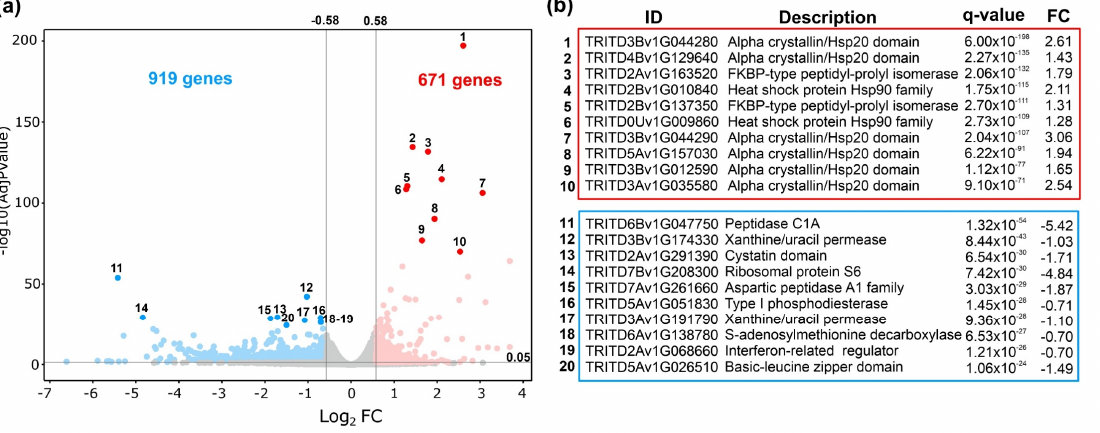
Figure 4. Volcano plot of differentially expressed genes identified between the heat-stress and control grain samples. ( a ) The blue dots denote downregulated gene expression (919 genes), the red dots denote upregulated gene expression (671 genes), and the gray dots represent genes under the threshold ( q -value < 0.05 and absolute fold of change (FC) > 1.5). Numbers represent the top 10 of down- and upregulated genes. ( b ) The upper panel (red) shows the ten most significant upregulated genes. Lower panel (blue) the ten most significant downregulated genes. ID: Gene identification from Triticum turgidum durum (Svevo.v1). Description: Gene family. FC: log 2 fold of change.